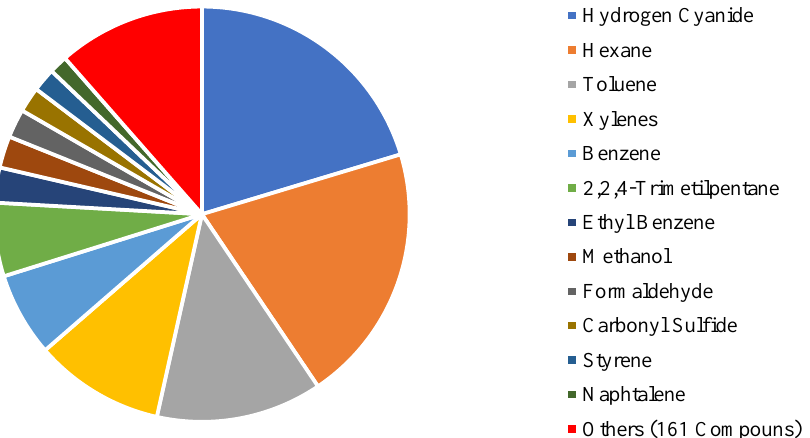
Figure 1. Contribution of the most present compounds to the total HAP emissions. From the list of compounds contained in Table 1 it is possible to highlight that there is a very limited contribution to the total emission of HAPs by aliphatic hydrocarbons, without heteroatoms, with a carbon number lower than 6 (i.e., only two light hydrocarbons are reported, 1,3-Butadiene and Hexane). The value of the Pearson correlation coefficient r evaluated considering only the above-mentioned compounds emitted from 109 refineries has been calculated and has a value of 0.79, thus highlighting a very strong linear